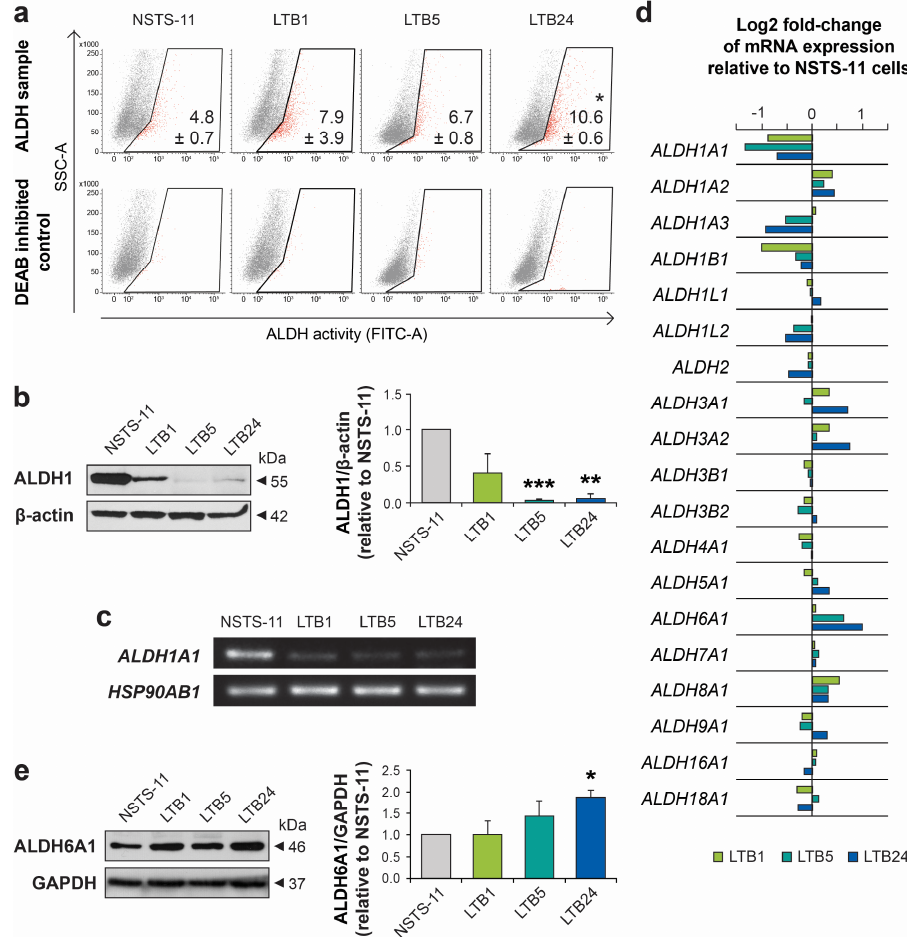
Figure 3. Aldehyde dehydrogenase activity and expression analysis. ( a ) Aldefluor™ assay showed an increase in aldehyde dehydrogenase (ALDH) activity over in vivo passages. Representative dot plots are shown. The percentage of ALDH-positive cells is presented as the mean ± SD of three independent experiments. * Statistically significant difference from parental NSTS-11 cells ( p < 0.05). ( b ) Western blot analysis of ALDH1 expression. β-actin served as a loading control. Representative image (left) and mean relative optical density values ± SD (right) of three independent experiments. ** p < 0.01, *** p < 0.001. ( c ) Expression of the ALDH1A1 gene as detected by RT-PCR. HSP90AB1 served as a control. ( d ) Microarray gene expression analysis of ALDH gene variants. ( e ) Western blot analysis confirmed upregulation of ALDH6A1 protein over in vivo passages. Glyceraldehyde-3-phosphate dehydrogenase (GAPDH) served as a loading control. Representative image ( left ) and mean relative optical density values ± SD ( right ) of three independent experiments. * p < 0.05.